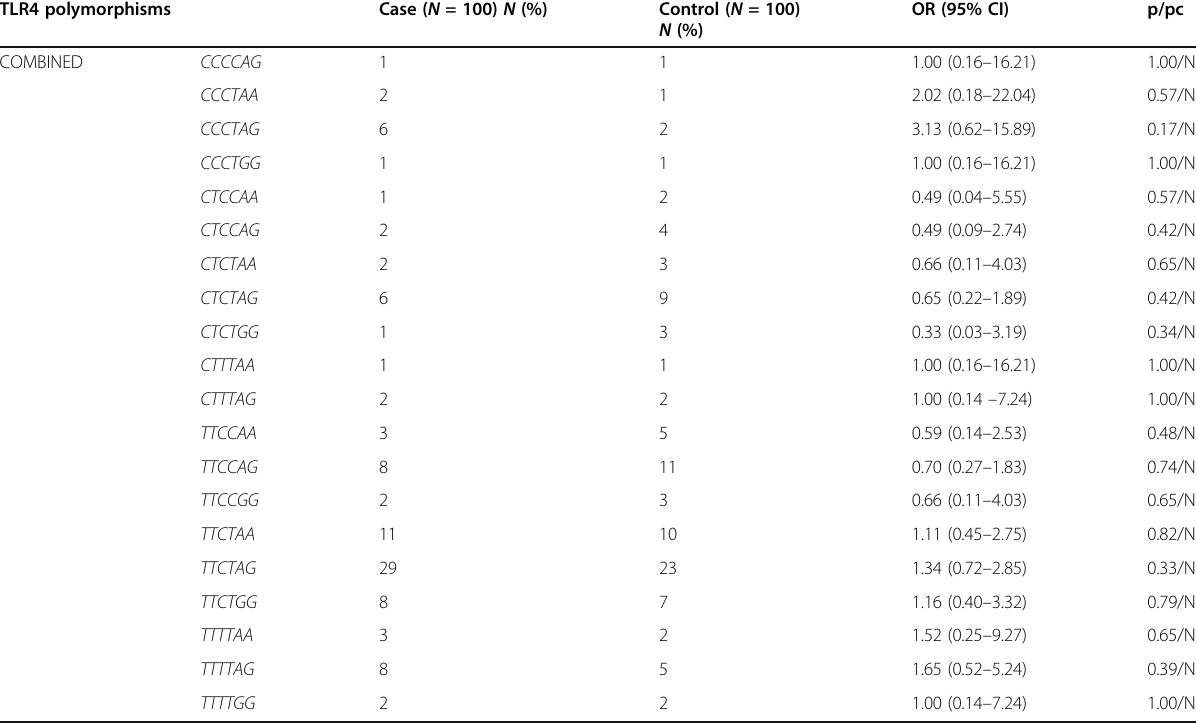
Table 7 Distribution of TLR4 combined genotypes in vitiligo patients and healthy controls